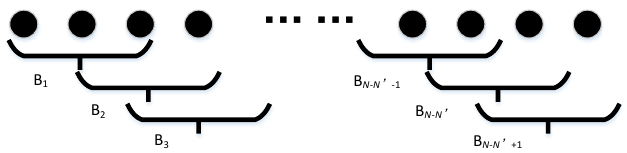
Figure 2. The framework of virtual sliding subarray.